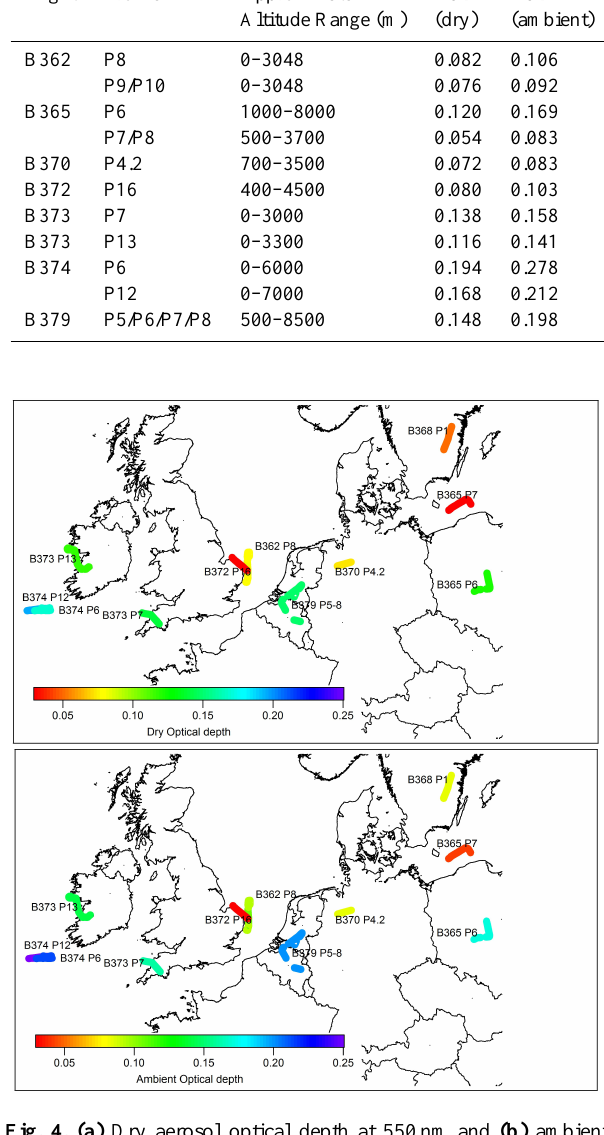
Fig. 4. (a) Dry aerosol optical depth at 550nm and (b) ambient optical depth at 550nm for deep profiles flown during